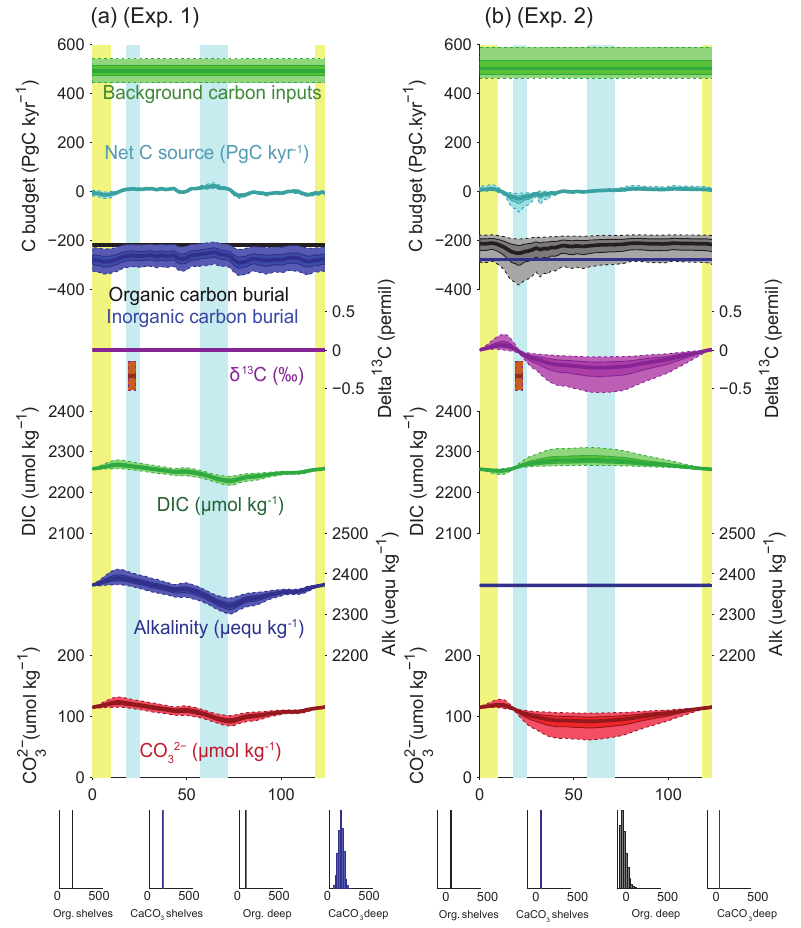
Figure 7. Simulated impacts of reconstructed deep burial fluxes on carbon and alkalinity inventories: (a) variable deep-sea CaCO 3 burial and (b) variable deep-sea C org burial. For each panel, the uppermost curves show the carbon budget terms (constant background carbon input, organic, inorganic carbon burial, and net flux from the geological to the active carbon reservoir) used to force the simulations. For each time series, the mean of the scenarios (thick line), ± 1 σ , and ± 2 σ are shown. Below are shown the simulated δ 13 C of the total active carbon pool, deep ocean alkalinity, deep ocean DIC, and implied deep ocean [CO 2 − ] (µmol kg − 1 ). The [CO 2 − ] only reflects changes in the alkalinity 3 3 and DIC inventories, not changes in ocean circulation or biology. An estimate for the whole-ocean δ 13 C by Peterson et al. (2014) during the LGM is also shown in orange (with upper and lower estimates). Vertical bars highlight cold periods (MIS2/LGM and MIS4) in blue and full interglacial conditions (Holocene and MIS5e) in yellow. The distribution of the modern fluxes used to drive the scenarios is shown by the histograms at the bottom of each